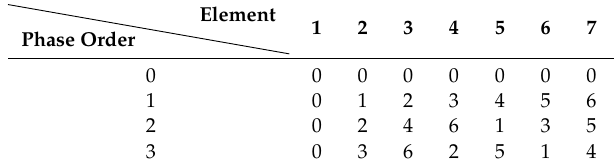
Figure 4. Geometrical construction of the patch array. Table 2. The phase distribution of array elements under different phase gradients (unit: 2 π /7 rad).